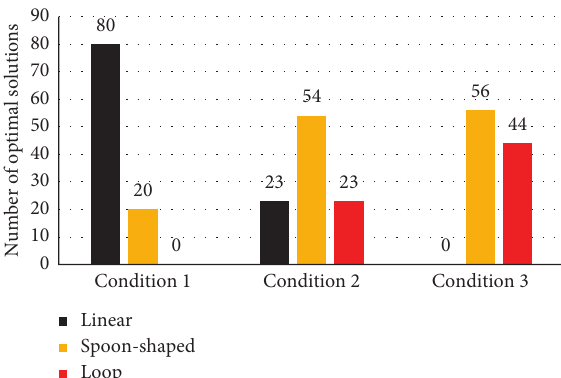
Figure 12: The shape distribution of the optimal solutions under three conditions.